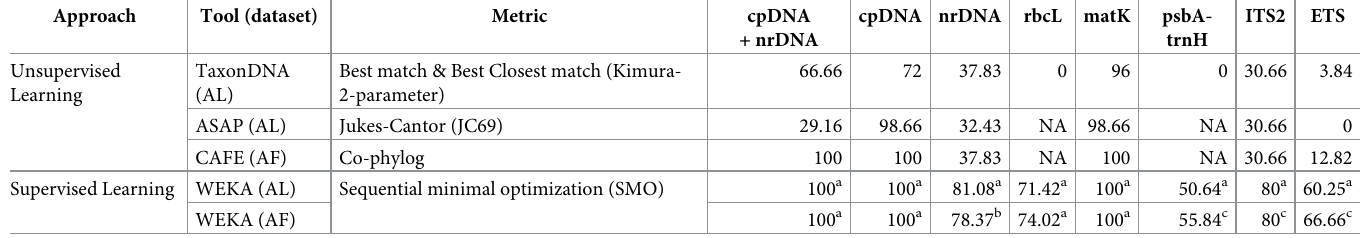
Table 1. Discrimination potential of multilocus barcode markers to differentiate RAK and UAQ populations using unsupervised and supervised learning approach.